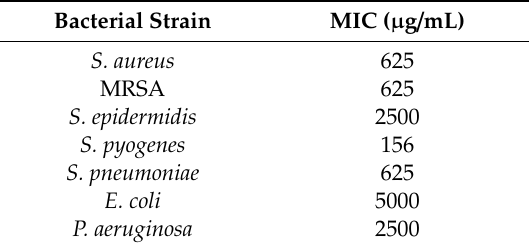
Table 4. Minimum inhibitory concentrations (MICs) of PP against di ff erent Gram + and Gram − bacterial strains.